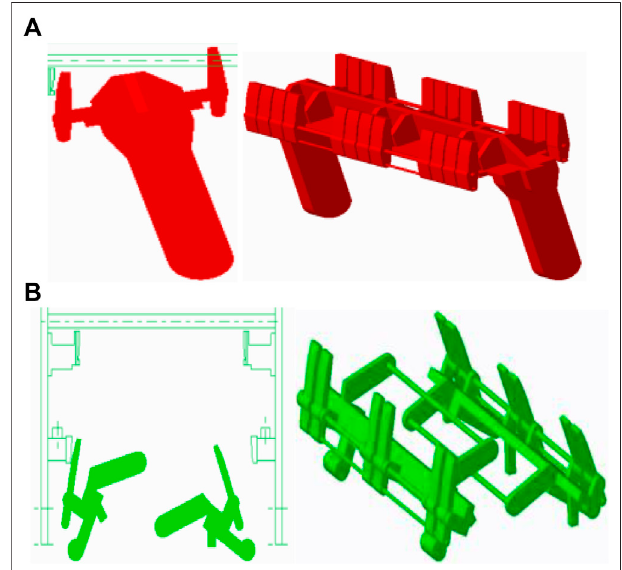
FIGURE 7 | Model of contacts and its fast mechanism. (A) Model of the main contact and its fast mechanism. (B) Model of the auxiliary contact and its fast